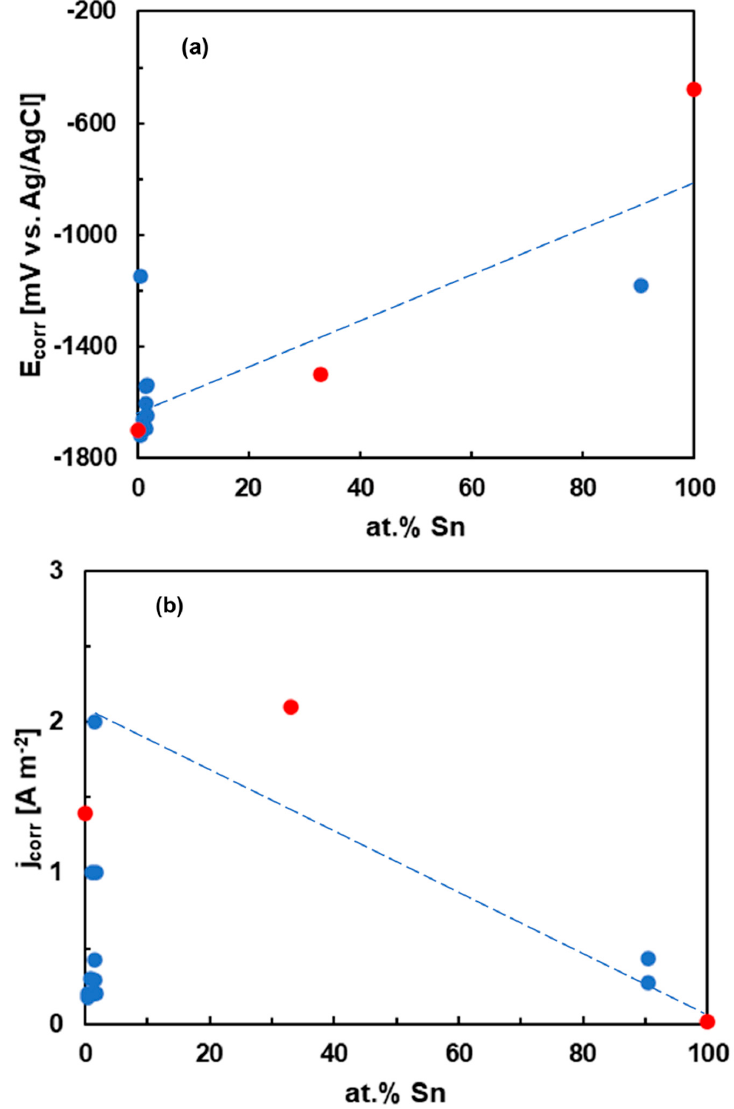
Figure 9. Corrosion potentials ( a ) and corrosion current densities ( b ) of Mg–Sn alloys in 3.5% NaCl. The present data are given in red. The dashed lines are guides to the eyes only.